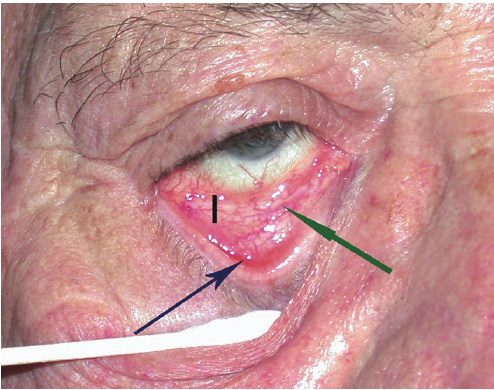
Figure 1: Patient with entropion of the right lower eyelid. Blue arrow demonstrates retractor dehiscence with “V” shaped junction between the retractors and the inferior border of the tarsus. Green arrow demonstrates the “white line.” Black bar indicates area of orbital fat prolapse.